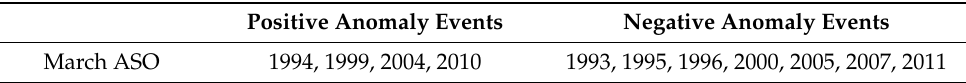
Figure 3. ( a ) Composite differences in April rainfall anomalies (mm/month; from GPCP) between positive and negative ASO anomaly events during 1985 – 2019. Detailed anomalous events can be found in Table 1. ( b ) Ratio of the composite differences to April precipitation climatology. Table 1. Positive and negative ASO anomaly events during the period 1985–2019. A positive (negative) ASO anomaly event is identified when the March ASO index, calculated from SWOOSH, is greater (smaller) than 1 ( − 1) standard